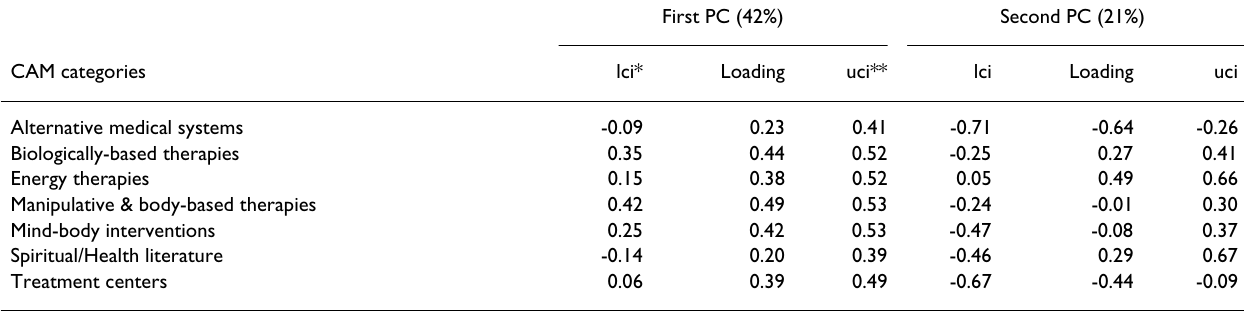
Table 4: Loadings with bootstrapped 95% confidence intervals for the first two principal components (PC).